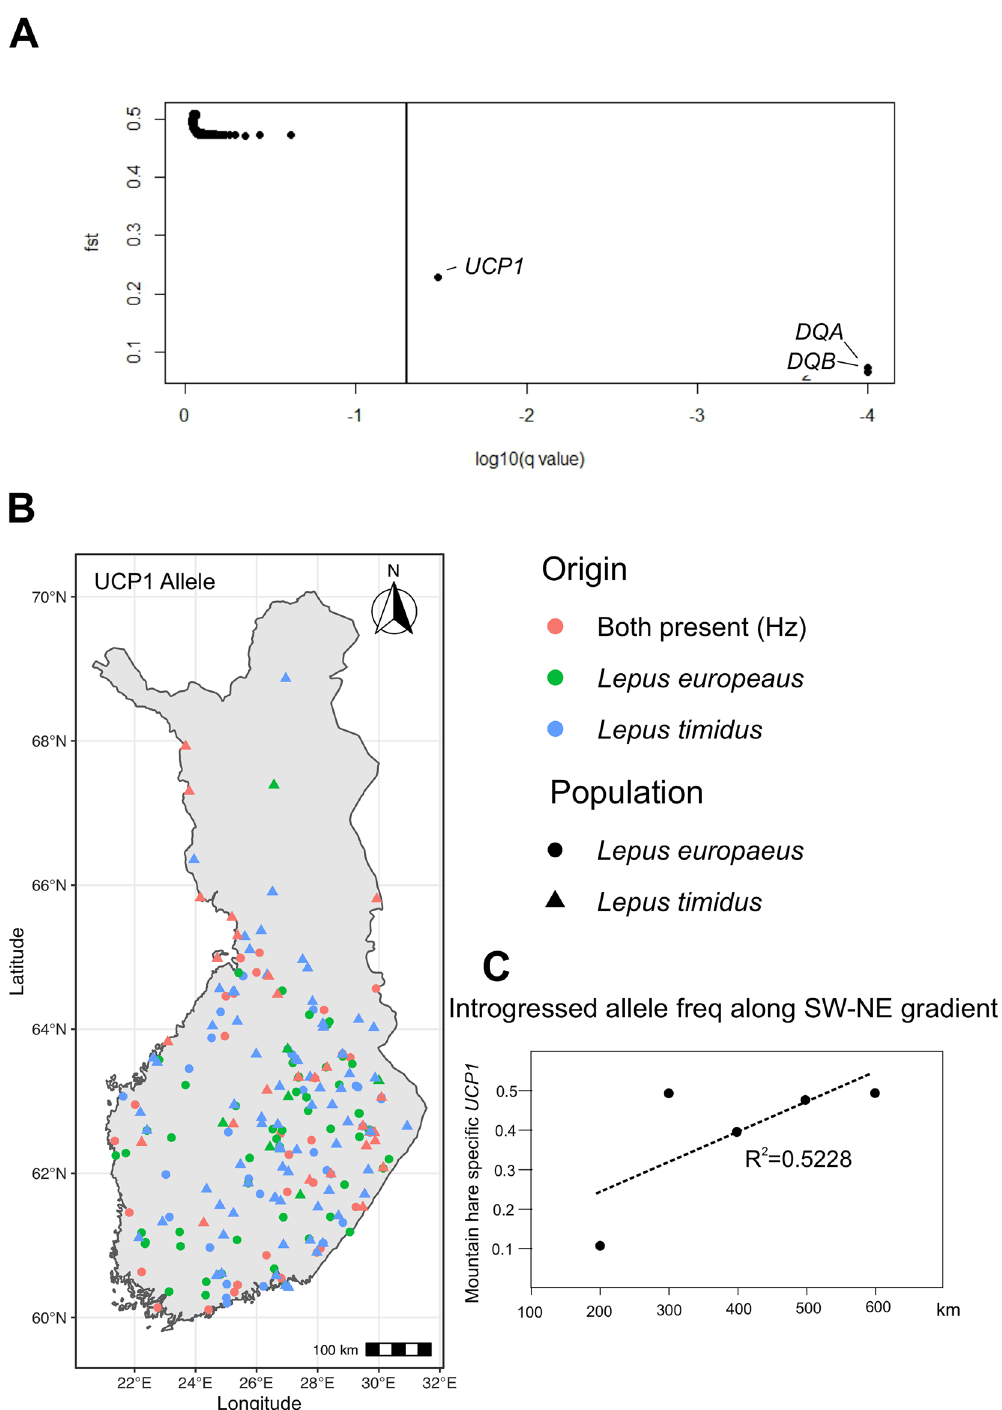
Figure 4. Potential selection advantage for UCP1 and MHC allleles. ( A ) A graph of the results of the Bayesian outlier analysis for loci under selection showing evidence of a strong balancing selection acting on the two MHC genes ( DQA : q = 0.0, F ST = 0.074, α = − 2.76; DQB : q = 0.0, F ST = 0.066, α = − 2.85) and moderate balancing selection for UCP1 (q = 0.033, F ST = 0.23, α = − 1.39). No selection was detected for TLR2 , SDHa or the included SNPs (the remaining dots). ( B ) Mountain hare specific UCP1 allele abundance in Finnish brown hares at each side of arbitrary SW-NE boundary, roughly following the median extent of 125 days of snow cover 6 . ( C ) Mountain hare specific UCP1 allele frequency gradient along the south-west to north-east